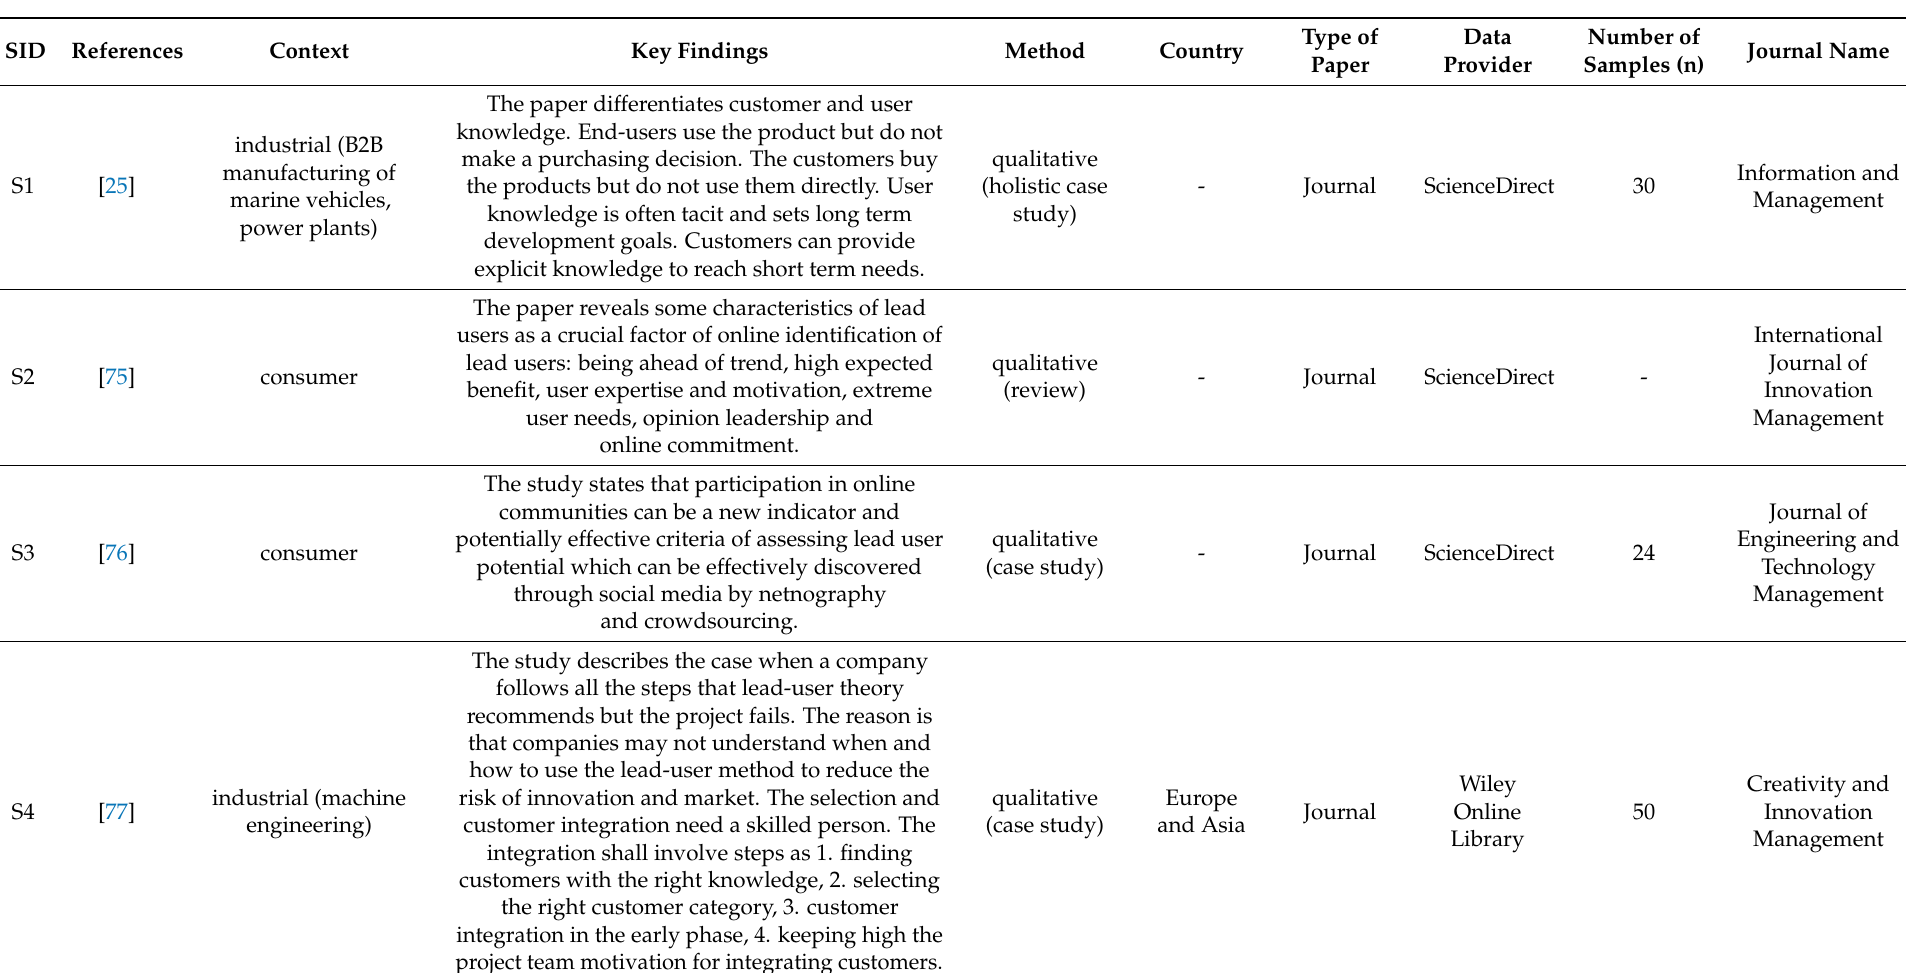
Table A1. Data Extraction